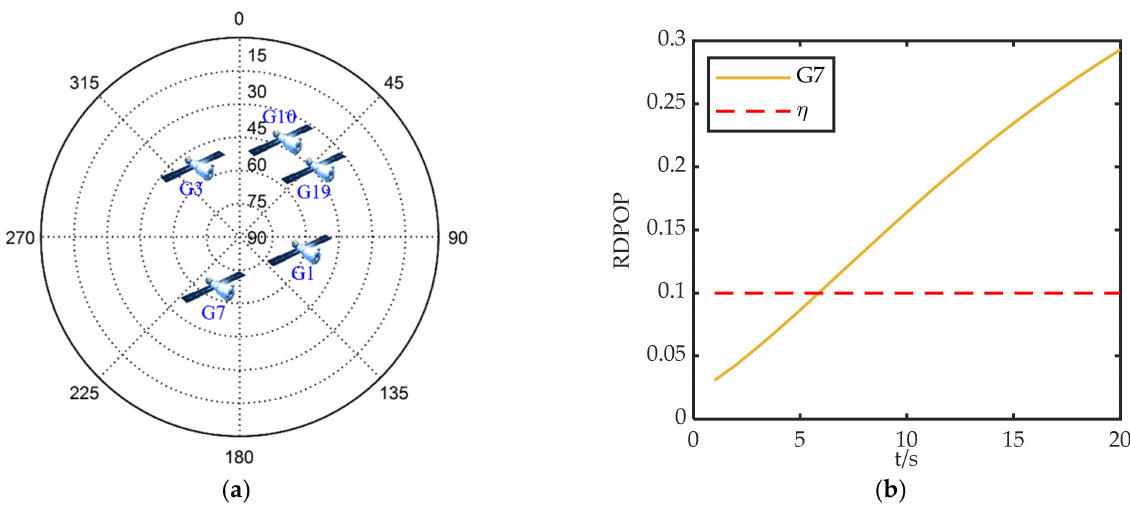
Figure 9. Satellite observation environment: ( a ) the configuration of the satellites; ( b ) RDPOP of faulty satellite.